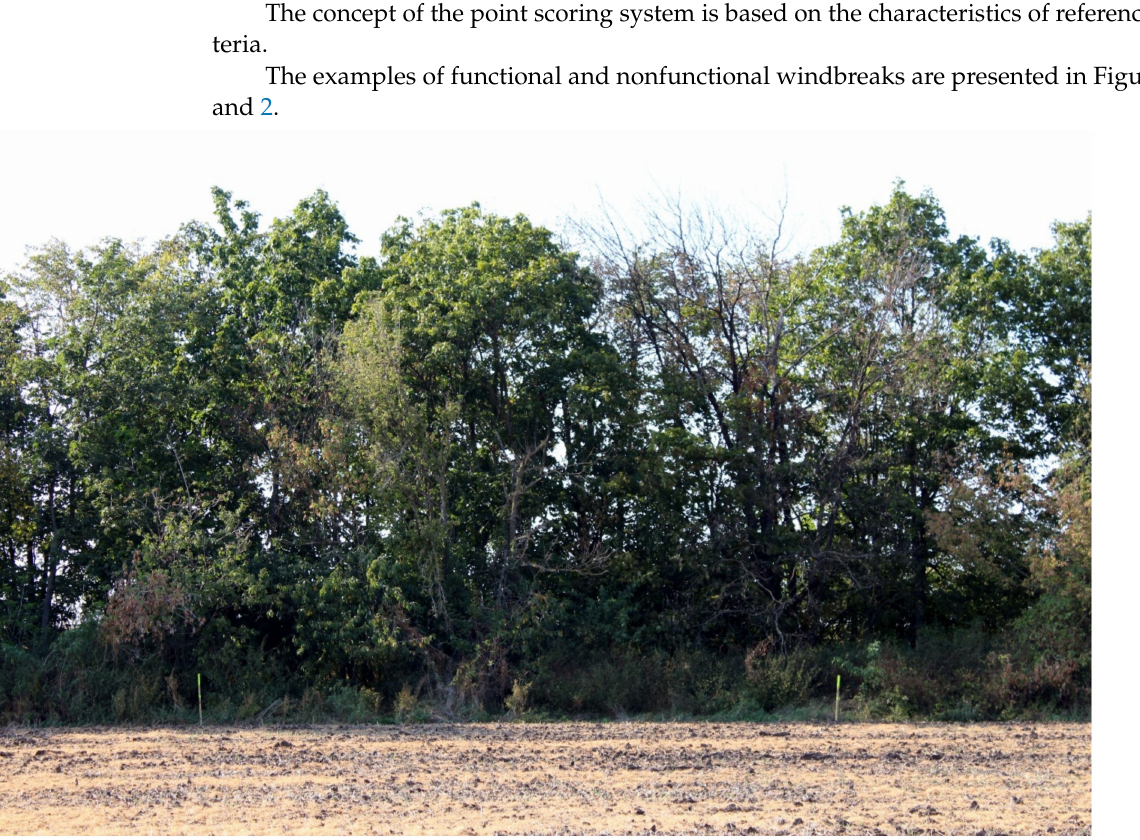
Figure 1. Functional type of